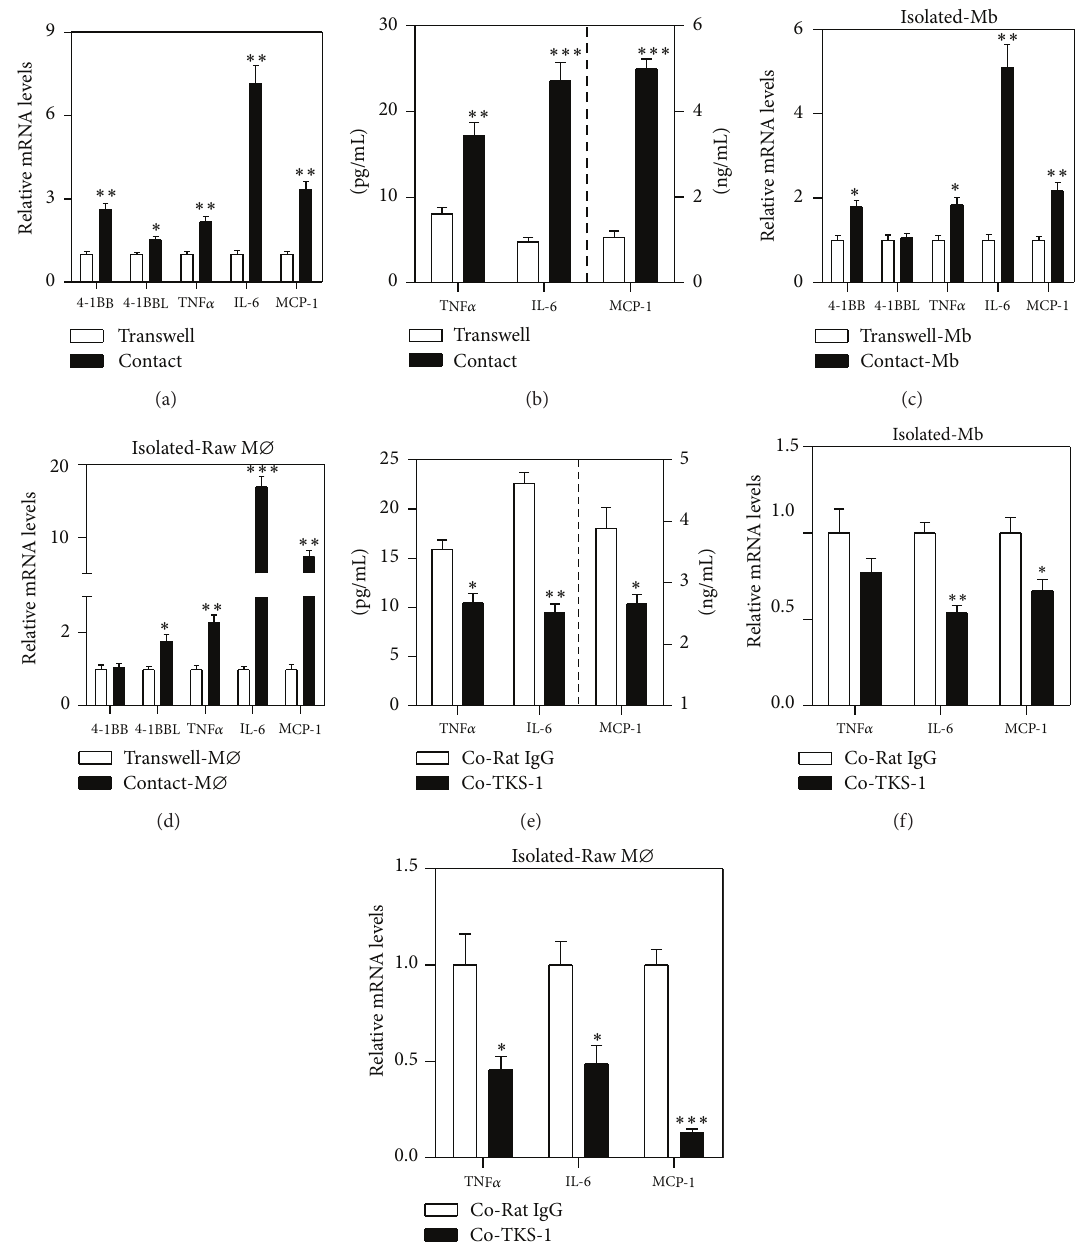
Figure 2: Inhibition of 4-1BB/4-1BBL interaction reduces inflammatory responses in myotube/macrophage coculture. C2C12 myotubes (Mb) were established for 3 days and then cocultured with Raw264.7 macrophages (M ⌀ ) (25%) in serum-free DMEM for 24h. ((a) and (b)) Raw macrophages were directly seeded into the plates containing established myotubes (Contact) or were added to transwell inserts (Transwell). (a) Expression of 4-1BB, 4-1BBL, and inflammatory cytokine (TNF 𝛼 , IL-6, and MCP-1) mRNAs was analyzed by qRT-PCR. (b) TNF 𝛼 , IL-6, and MCP-1 proteins released in the culture media were measured by ELSA. ((c) and (d)) Myotubes and Raw264.7 macrophages in the contact cocultures (Contact-Mb/M ⌀ ) or the transwell cocultures (Transwell-Mb/M ⌀ ) (control) were separated using a CD11b MicroBeads system. Expression of 4-1BB, 4-1BBL, and inflammatory cytokine mRNAs in isolated myotubes (c) and in isolated-Raw macrophages (d) was analyzed by qRT-PCR. (e–g) Raw264.7 macrophages were seeded onto myotubes with or without pretreatment with neutralizing anti-4-1BBL antibody (TKS-1, 5 𝜇 g/mL) or rat IgG (5 𝜇 g/mL) in serum-free DMEM for 24h. (e) TNF 𝛼 , IL-6, and MCP-1 proteins released in the culture media were measured by ELISA. ((f) and (g)) Myotubes and Raw264.7 macrophages in the TKS-1- or rat IgG-treated cocultures were separated using a CD11b MicroBeads system. Expression of inflammatory cytokine mRNAs in isolated myotubes (f) and in isolated-Raw macrophages (g) was analyzed by qRT-PCR. Data are means ± SEM of three independent triplicate experiments. ∗ 𝑃 < 0.05 , ∗∗ 𝑃 < 0.01 , and ∗∗∗ 𝑃 < 0.001 compared with